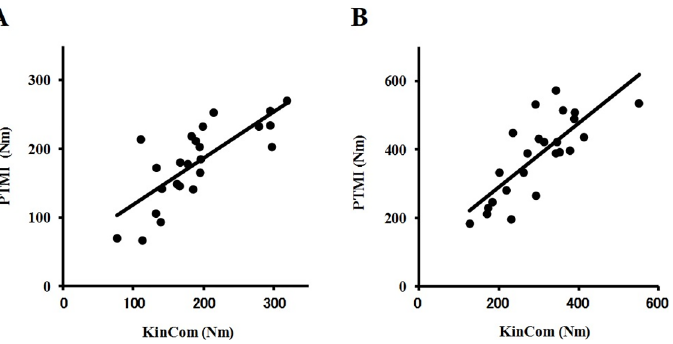
Fig 2. Scatter plot of flexion and extension torque by KinCom and the PTMI instrument. The flexion torque (A) and extension torque (B) were recorded using each instrument.